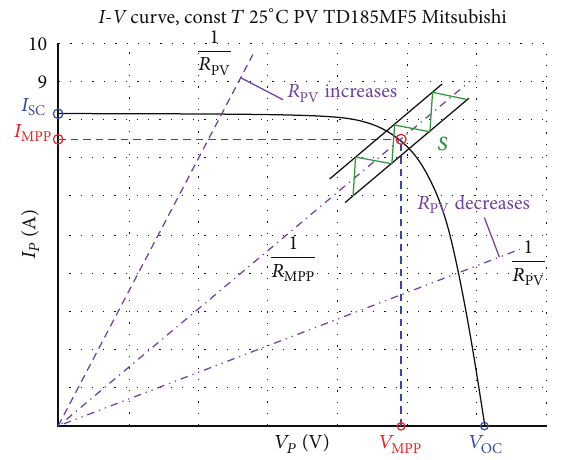
Figure 16: Behavior of the 𝑅 PV related to the characteristic curve.